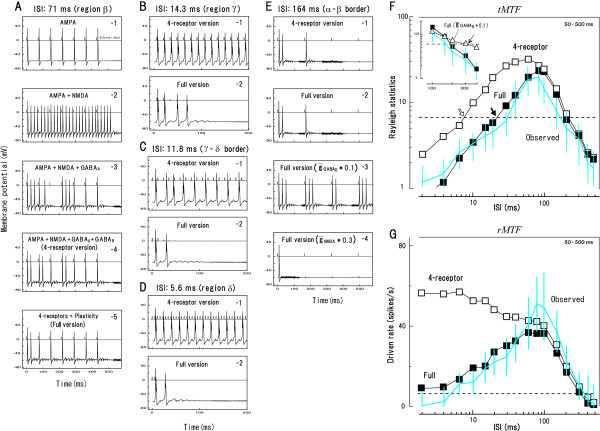
A single-cell dynamic model replicates the response kinetics of the synchronization neurons. The simulation was made on various combinations of the receptors (AMPA, GABAA, NMDA and GABAB receptors) with/without frequency-dependent depression (FDD) and paired-pulse facilitation (PPF) (depicted in each panel). Measures were generated by averaging responses over 20 simulations for each condition. A-E: Membrane potentials obtained at ISI of 71 ms (at the best ISI, region β; A), 14.3 ms (region γ; B), 11.8 ms (γ-δ border; C), 5.6 ms (region δ; D) and 164 ms (α-β border; E). F, G: The tMTF (F) and rMTF (G) obtained under various conditions. Measures were filtered by a weighted average with its 5 neighbors in the ratio of 1:2:3:2:1. Gray curve: the mean (with SD) of physiological data for the synchronization type with band-pass tMTF (based on 2A-1 for Fig. 8F, and 2A-2 for Fig. 8G). In F, the broken line denotes statistically significant level (P ≤ 0.05; Rayleigh Z-test) and the arrows indicate β-γ border (open, filled) or α-β border (dotted) in various conditions. See Methods for details.